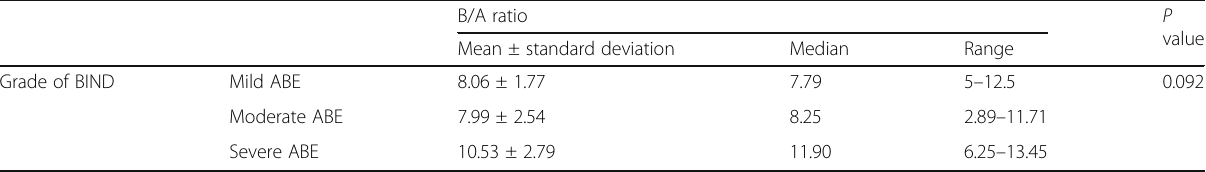
Table 8 Relation between BIND score and B/A ratio in patients with neurological manifestation